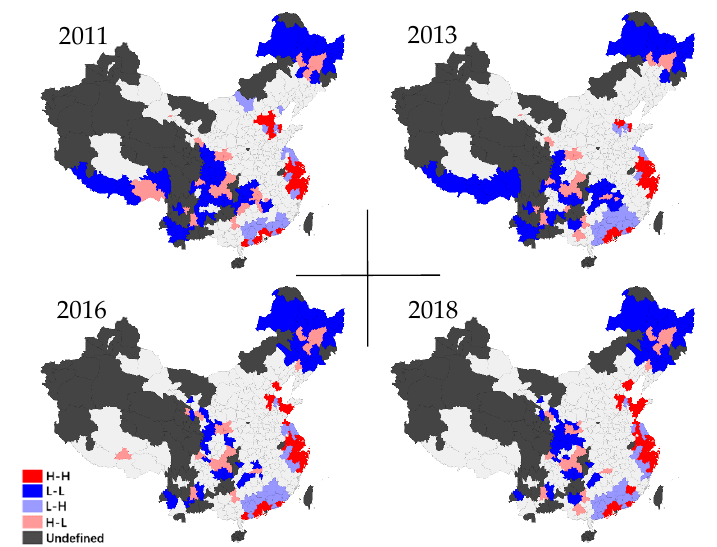
Figure 6. Evolution characteristics of regional spatial patterns of new-urbanization levels in Chinese cities.